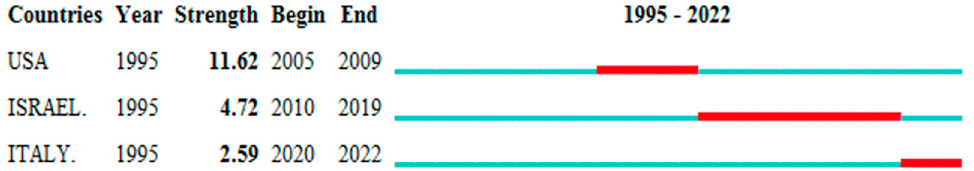
Figure 2. Distribution of articles by country.